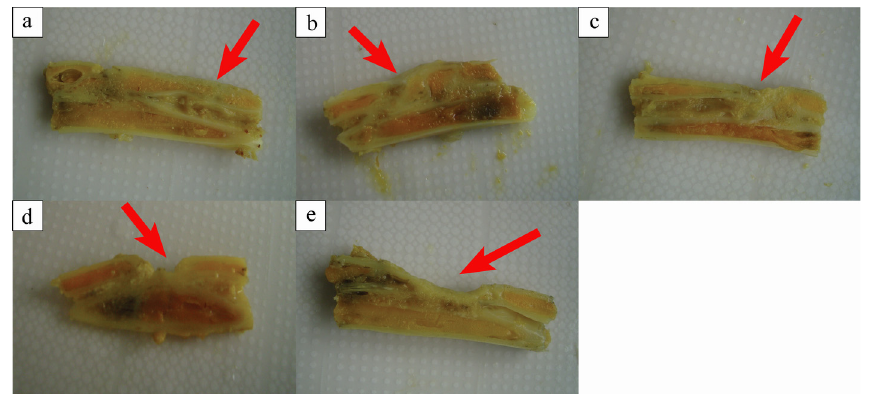
Fig 8. Gross observation of different radius defects cut through longitudinal section after decalcification. The central defect size was reduced with the increase of created defect size (a: 1.0cm, b: 1.2cm, c: 1.4cm, d: 1.7cm, e: 2.0 cm).